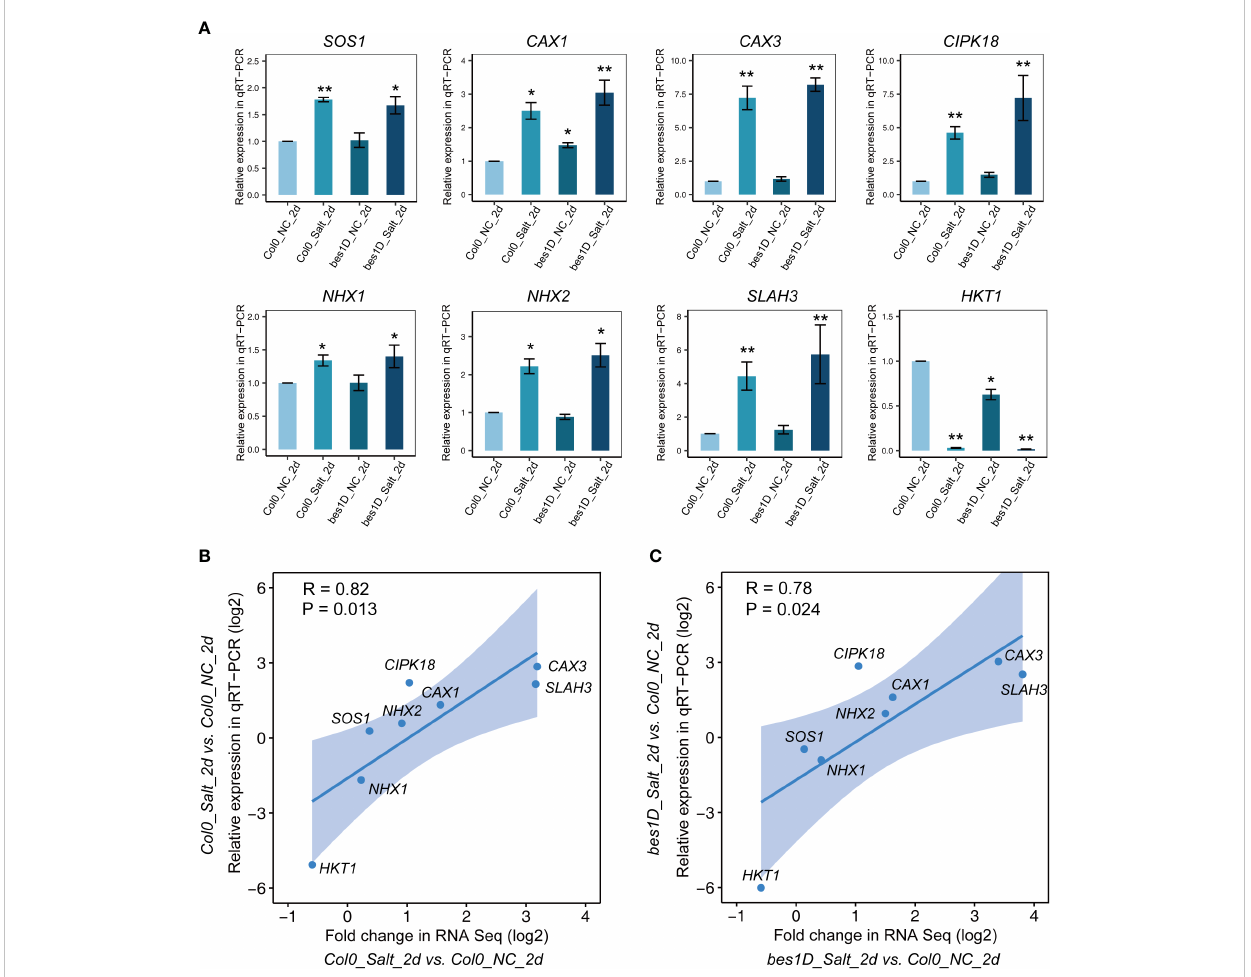
FIGURE 5 Validation of selected genes by qRT-PCR and the correlation coef fi cient analysis of qRT-PCR and RNA seq. (A) qRT-PCR results of SOS1 , CAX1 , CAX3 , CAX7 , NHX1 , NHX2 , SLAH3 , and HKT1 in Col-0 and bes1-D under salt stress. NC, normal conditions; Salt, 150 mM of NaCl. The sample Col- 0_NC_2d was used as control for other experimental samples. A housekeeping gene UBQ10 (AT4G05320) was adopted as an internal reference for normalization of gene expression values. Relative expression values were calculated by using 2^( − DD Ct) method. Error bar means SE value of three biological repeats for each gene. Stars above error bars denote signi fi cant differences compared to Col-0_NC_2d (* P < 0.05, ** P < 0.01, ANOVA and Tukey ’ s HSD). (B, C) Evaluation of the correlation coef fi cient between fold changes in RNA Seq and relative expression in qRT-PCR of selected genes. Pearson correlation coef fi cient between the two groups and its signi fi cance ( P value) were calculated by using ggpubr package in